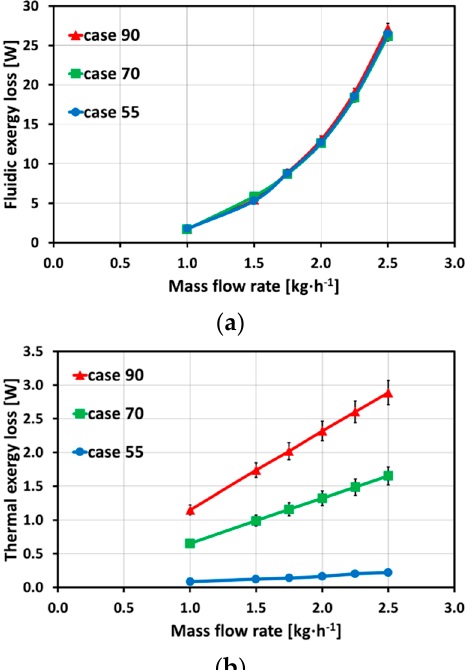
Figure 7. Fluidic exergy loss ( a ) and thermal exergy loss ( b ) for case 90, case 70, and case 55 (with a maximum uncertainty of fluidic exergy loss of Δ ( Δ E P ) = ±0.6 W and a maximum uncertainty of thermal exergy loss of Δ ( Δ E T ) = ±0.2 W).